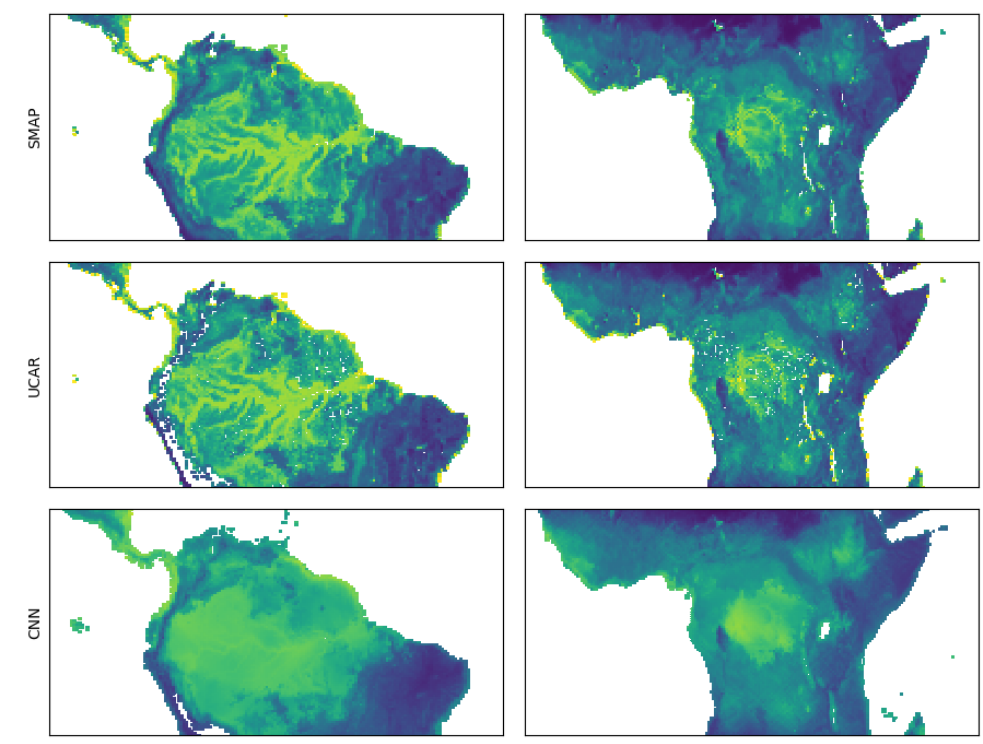
Figure 13. Comparison of the Amazon region ( left ) and the Congo region ( right ) between SMAP ( top ), UCAR ( middle ), and CNN ( bottom ). Regions with high soil moisture (yellow) in upper two plots are associated with low-quality SMAP values, which were excluded from the training process.